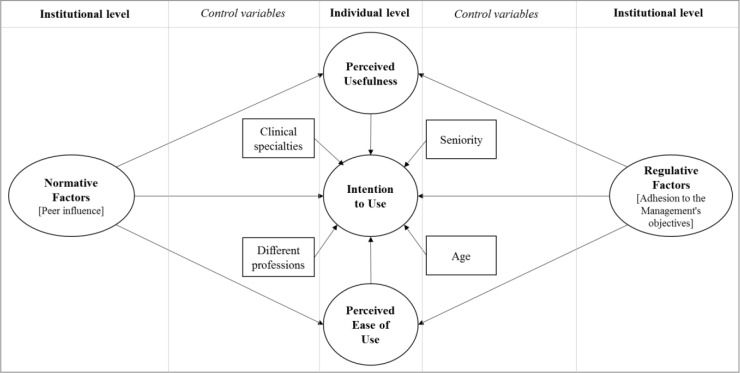
Research framework.